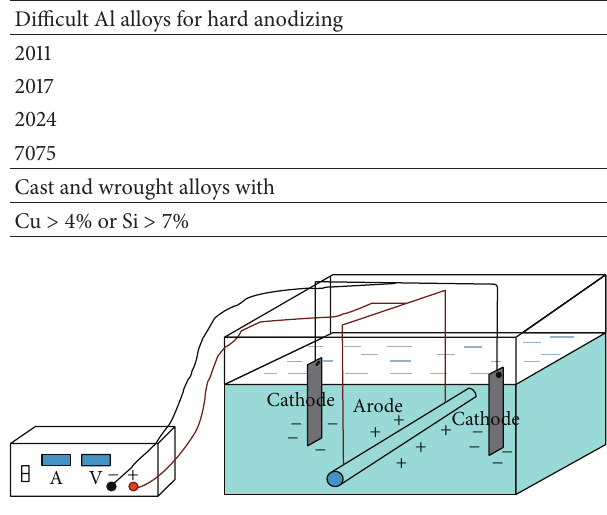
Figure 15: The schematic of hard anodizing process